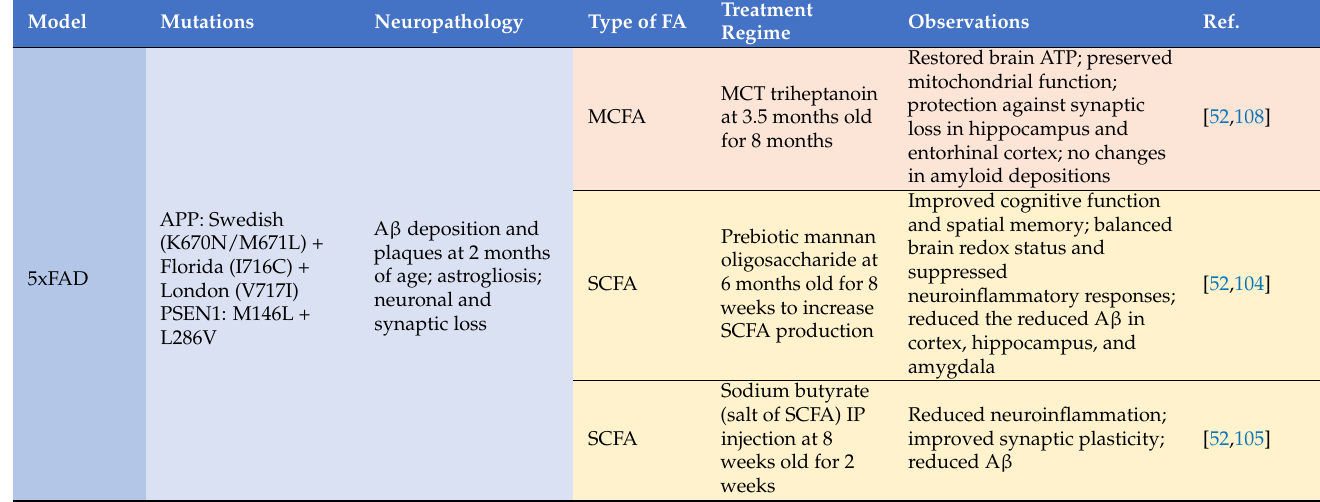
Table 1. Comparison of current AD mouse models studying SCFAs and